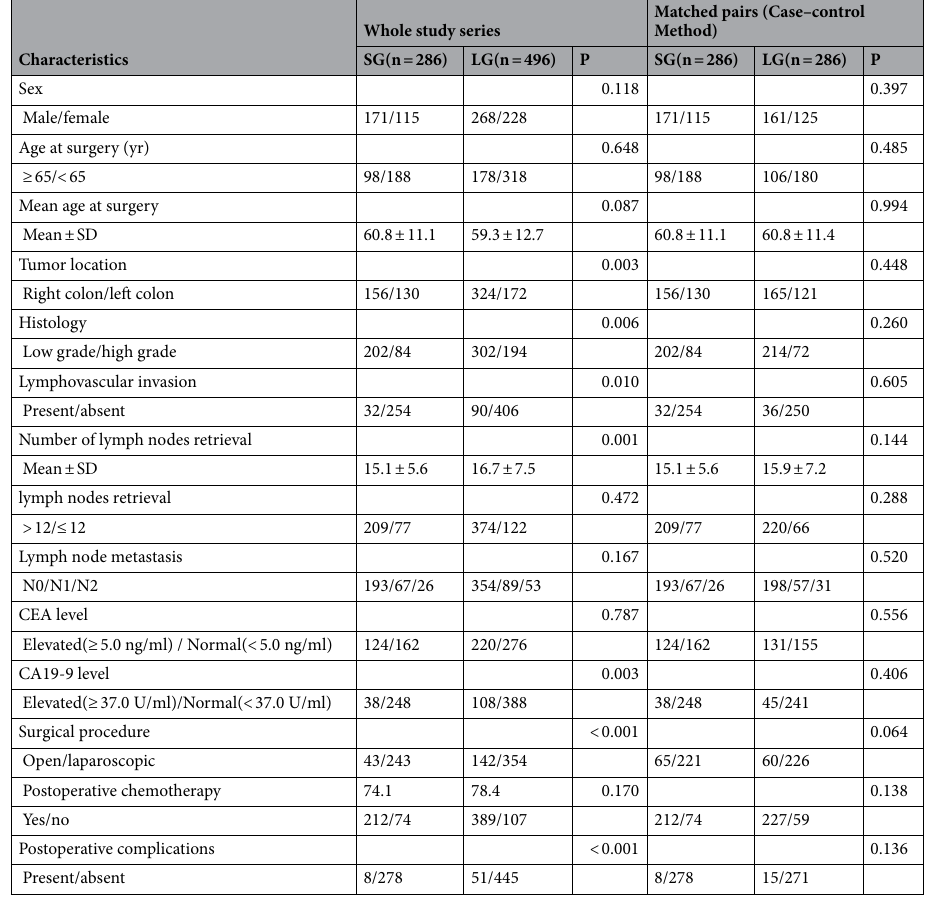
Table 1. C linicopathological features of T4a CC patients grouped by tumor size: data are reported for the whole study series and for one-to-one propensity-score matched